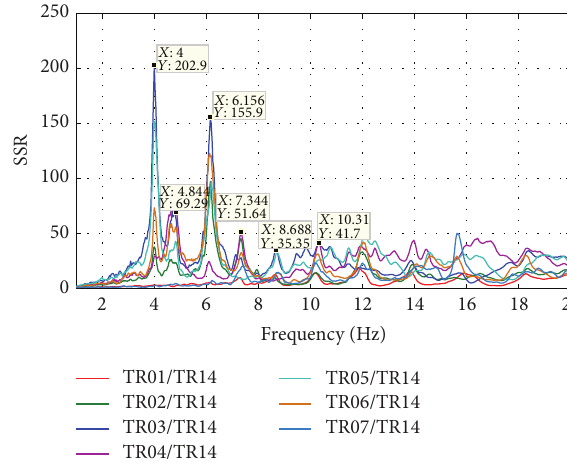
Figure 6: Radial spectral ratios at the dam crest (October 2012).